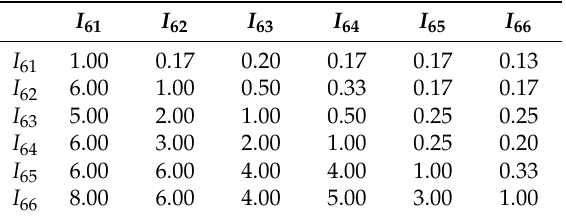
Table A7. Judgment matrix of the synergy process index.